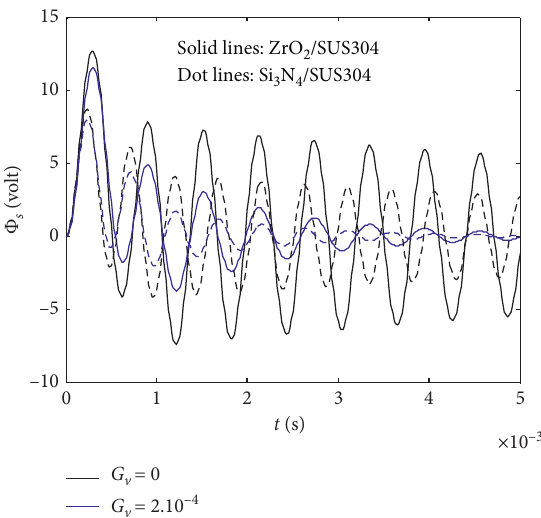
Figure 10: The dependence of w � 1, k